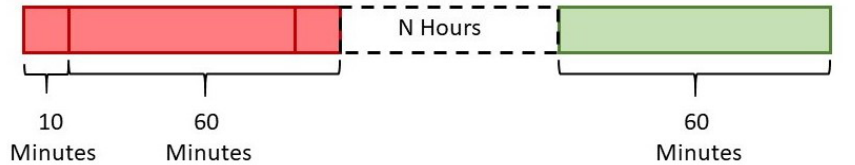
Figure 3. The time-windows for feature extraction (red) comprised of two overlapped windows of 60 min each with an overlap of 50 min resulting in 70 min to predict the statistics of the target window (green) after N hours (e.g., 0,1, or 2